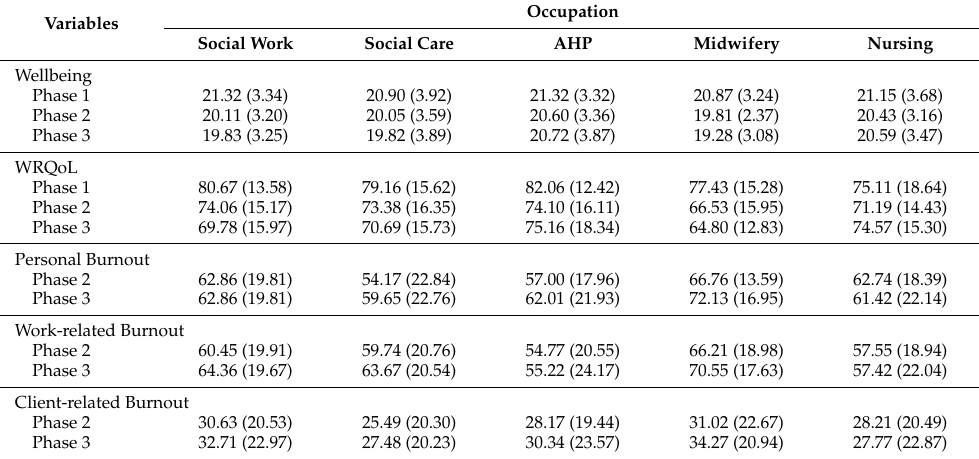
Table 2. Means and standard deviations (in brackets) for the wellbeing, work-related quality of life (WRQoL) and Burnout by occupation and across